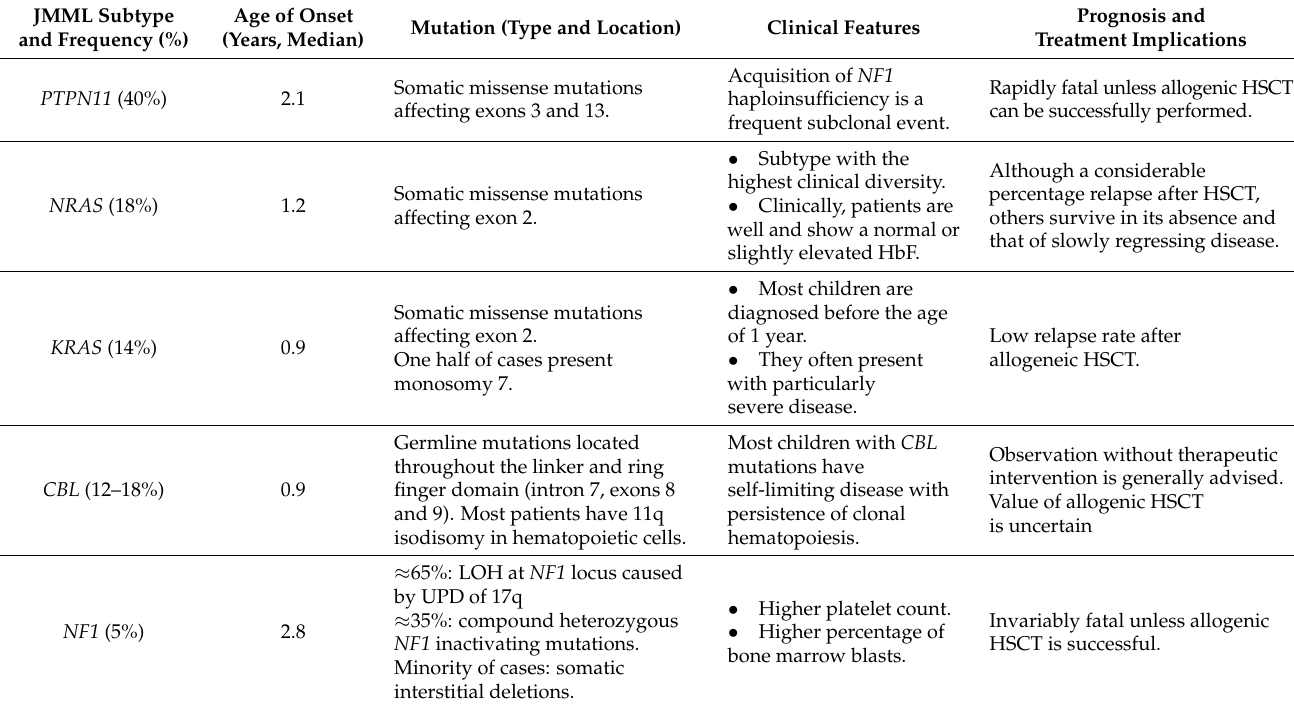
Table 3. Genetic subtypes of JMML with most relevant